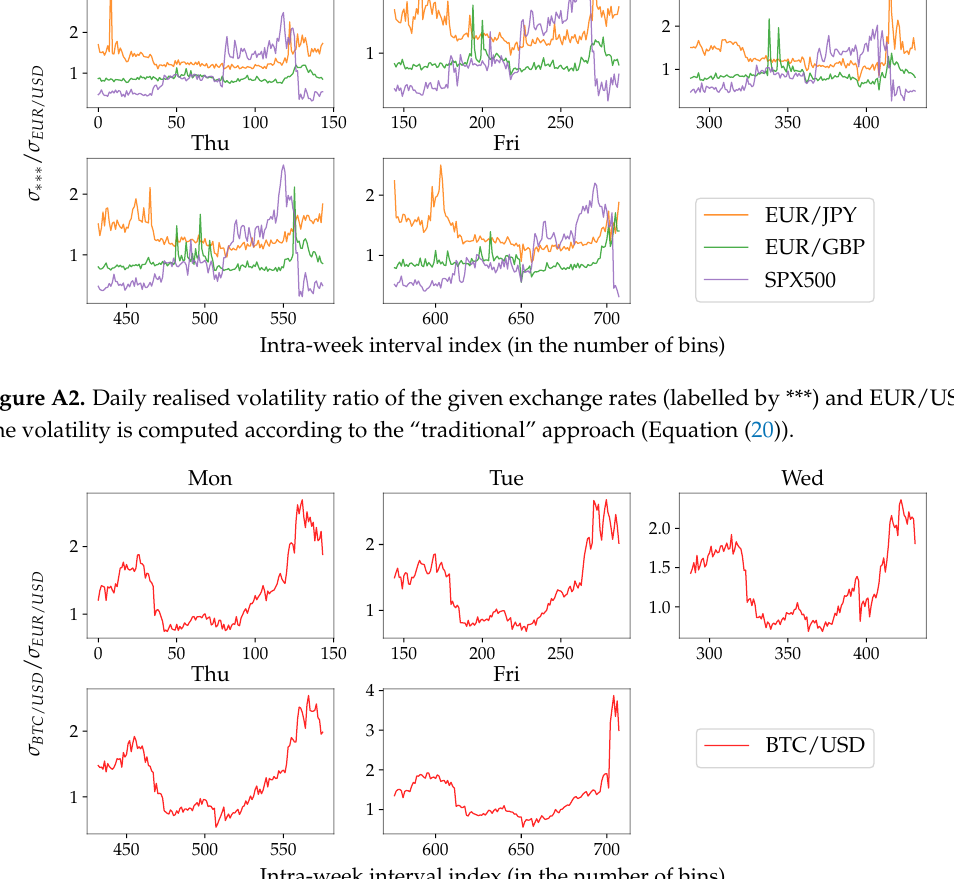
Figure A3. Daily instantaneous volatility ratio of BTC/USD measured over 10-min time intervals dissecting the entire week into 1008 bins. The volatility is computed according to the novel approach (Equation